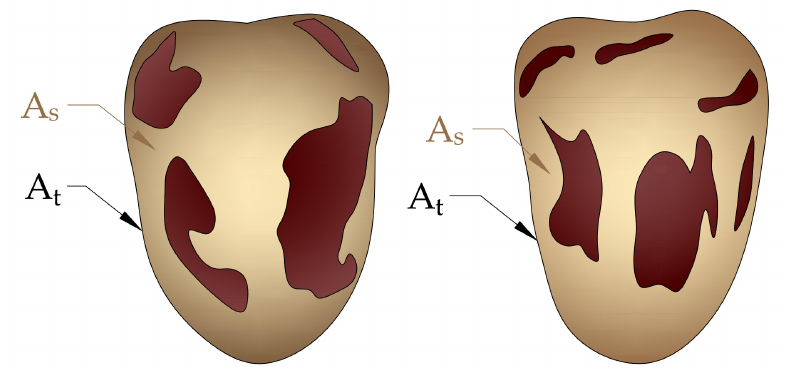
Figure 8. Projected area of the tested date fruit; (A s ) the separated skin projected area and (A t ) the total projected area of the tested date fruit.